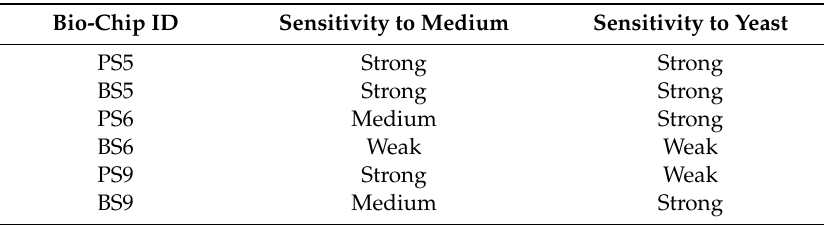
Table 2. Sensitivity level for the manufactured biochips to DI water and to yeast. 20 µ L DI water and 1 µ L S. cerevisiae inserted to the ring top electrode for testing the sensitivity of the biochips to medium and to yeast,